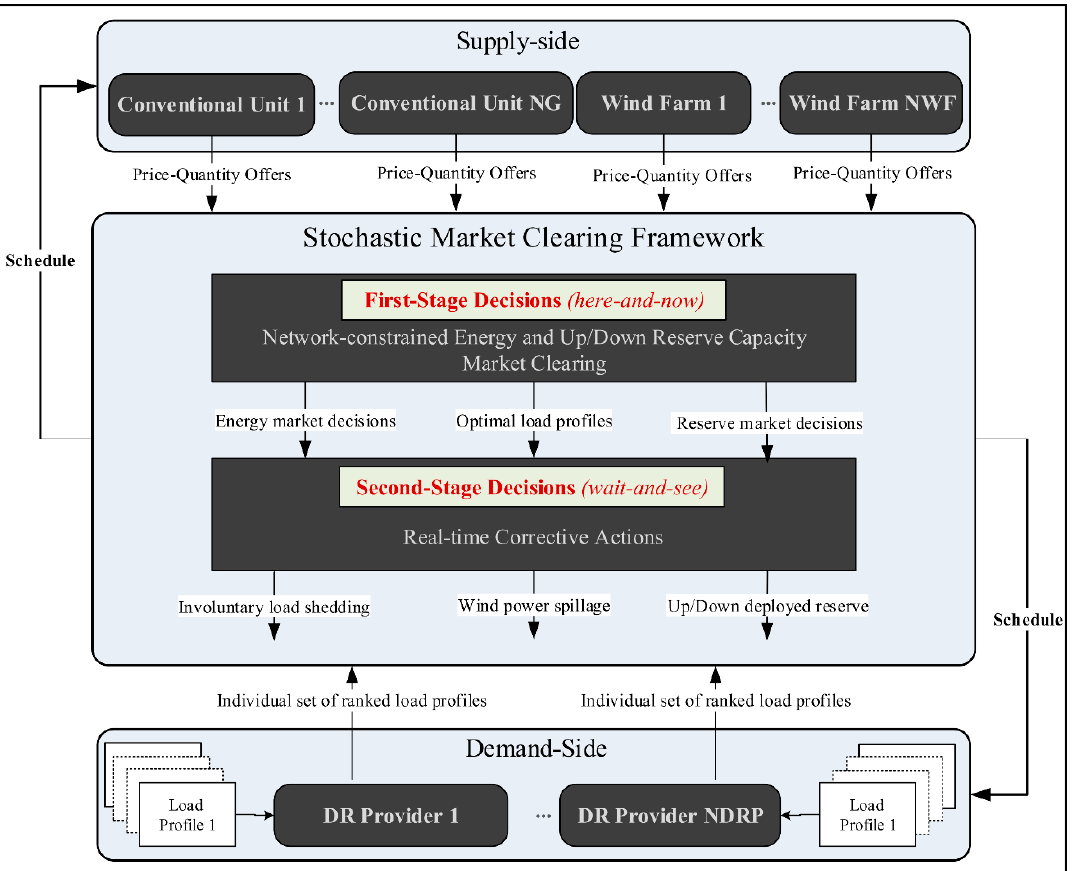
Figure 1. Conceptual schematic of two-stage stochastic market clearing in the presence of an autonomous demand response (ADR).